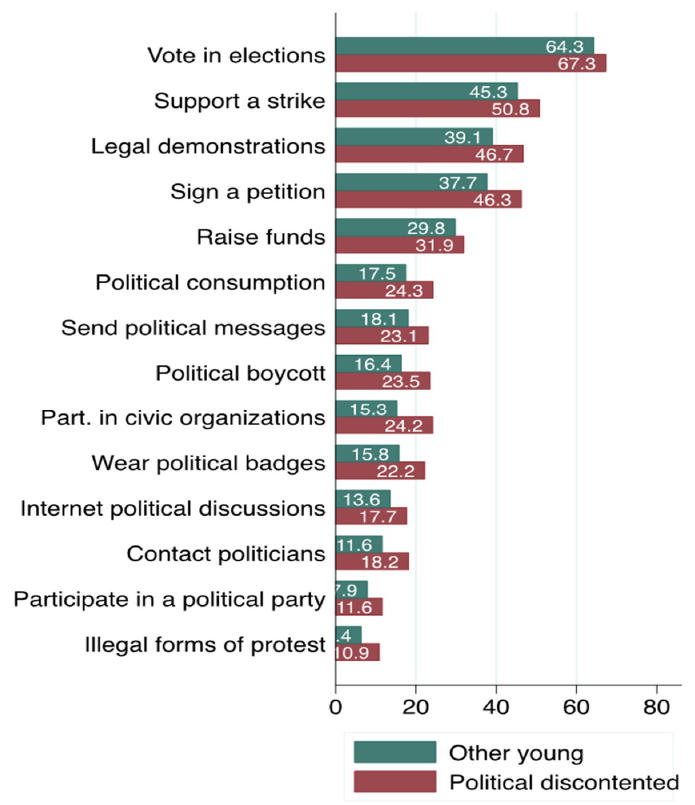
Figure 10. Forms of political participation. Percentage of young people who had participated at least